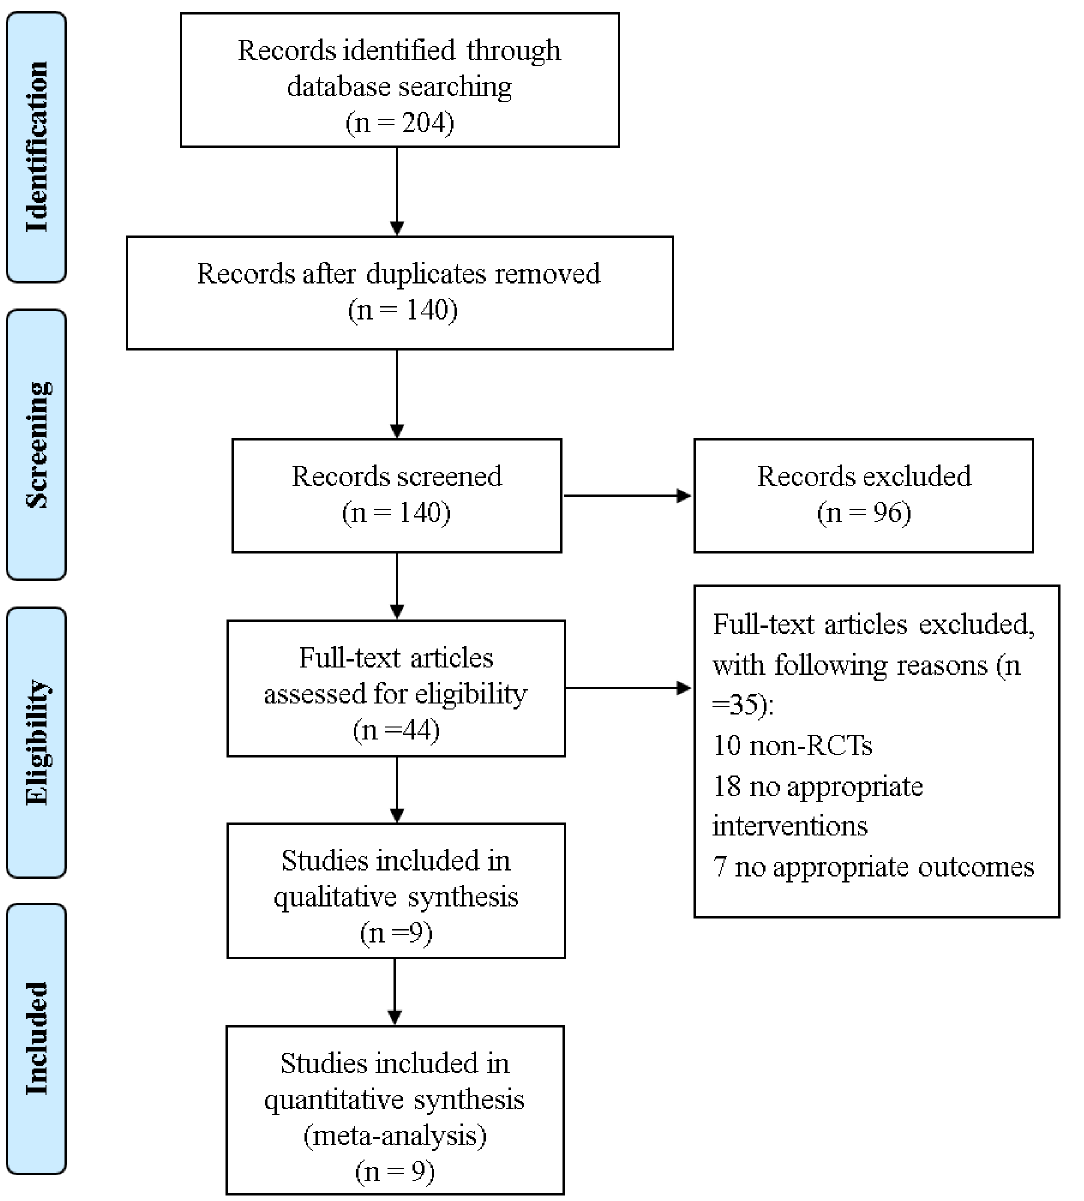
Fig 1. Flow Chart of Study Search and